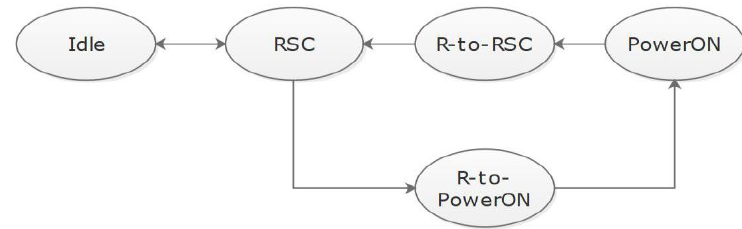
Figure 9. The state machine of Inv n . Table 3. States description.